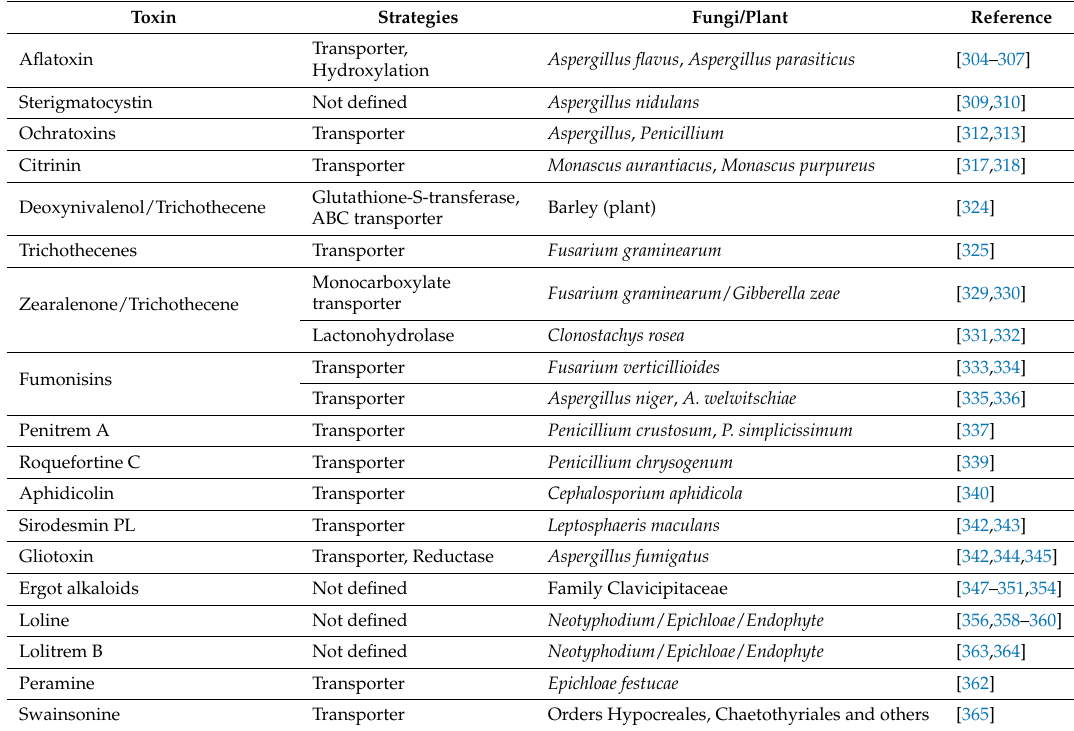
Table 4. Toxin resistance-related strategies in